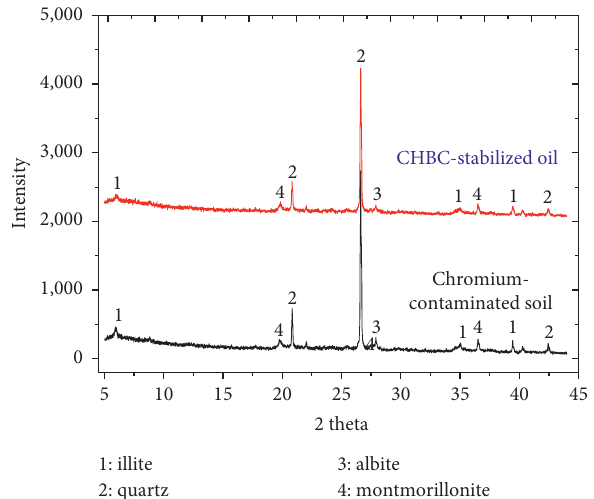
Figure 9: The XRD patterns of the Cr(VI)-contaminated soil and CHBC stabilized